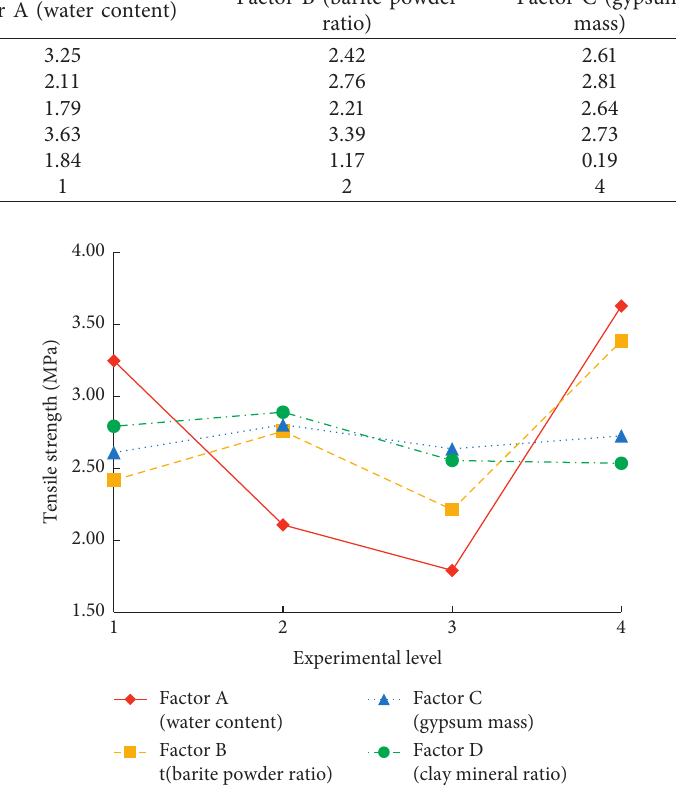
Figure 7: Range analysis of the factors affecting tensile strength. Table 13: Variance analysis of tensile strength.